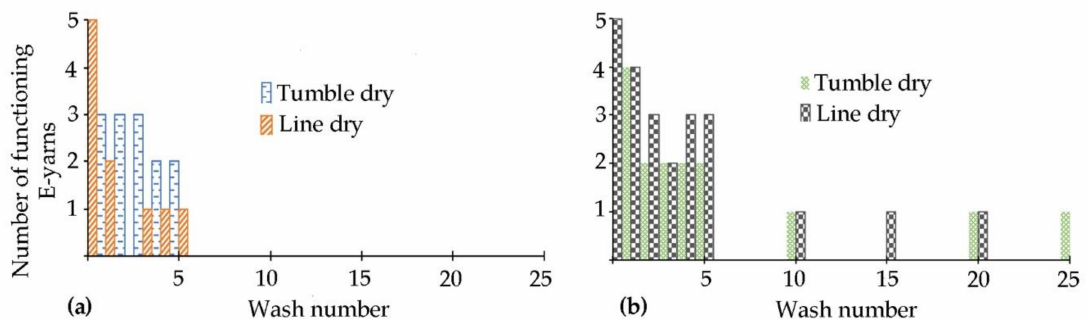
Figure 11. The number of working acoustic sensing E-yarns measured after wash 1, 2, 3, 4, 5, 10, 15, 20 and 25 for: ( a ) acoustic sensing E-yarns within pockets attached to T-shirts; ( b ) acoustic sensing E-yarns within channels in a woven fabric.